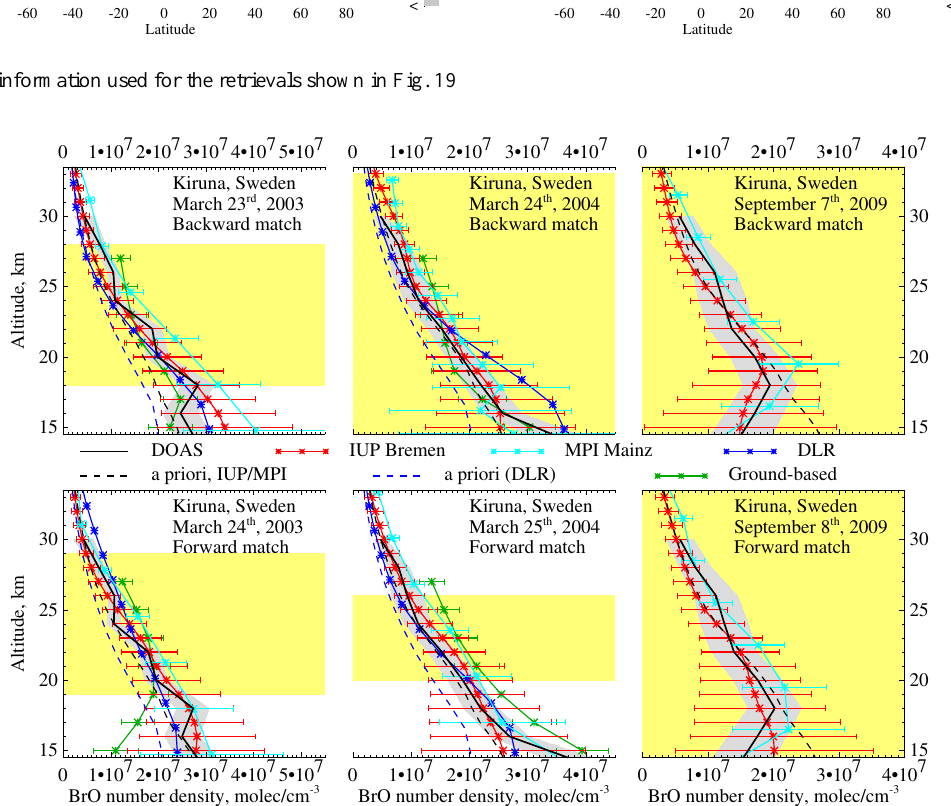
Fig. 21. Comparison of BrO vertical distributions retrieved from SCIAMACHY limb measurements using different retrieval algorithms to coinciding balloon-borne DOAS observations. When available, ground-based UV-visible BrO profiles from the Harestua station are also shown. All balloon launches are in Kiruna (high latitude). Left panels: 23 March 2003. Middle panels: 24 March 2004. Right panels: 7 September 2009. Gray shadings depict the uncertainties of DOAS results (1- σ ). Yellow areas mark vertical ranges where according to trajectory model calculations both instruments probe the same air